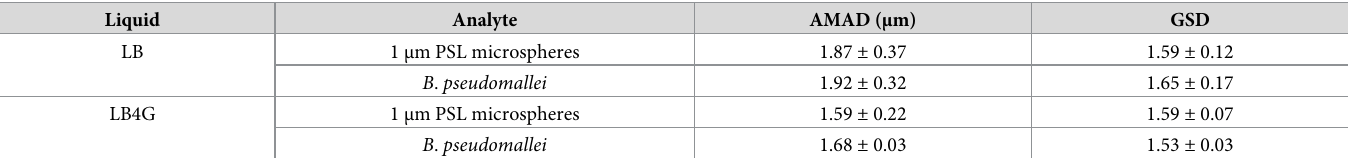
Table 1. Particle size distributions measured by Mercer cascade impactor. The suspension medium had a small but significant effect on the AMAD (P = 0.0317), but neither the analyte nor the interaction between analyte and suspension medium was a significant factor. There was not a significant difference between the GSDs as a func- tion of suspension medium, analyte, or their